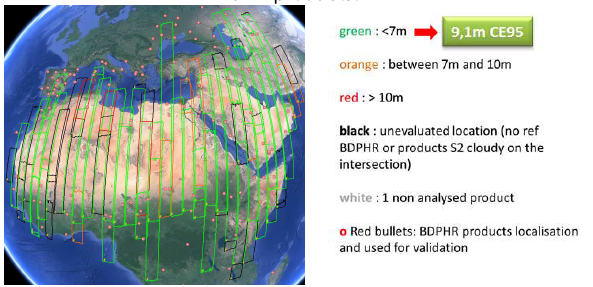
Figure 10. BDPHR number per North Africa and Middle East GRI products.